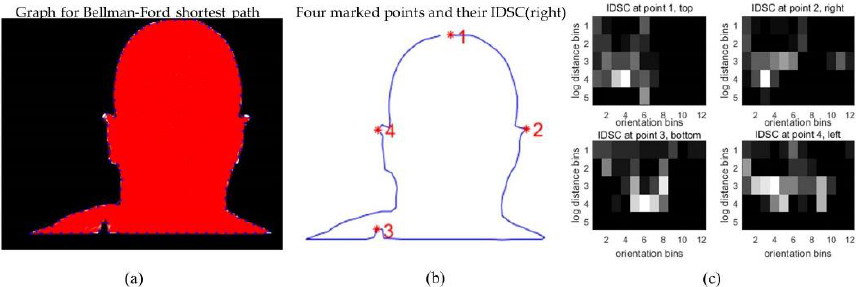
Figure 2. Schematic illustration of face silhouette feature descriptors based on Inner-Distance Shape Context (IDSC). ( a ) Bellman-Ford shortest path graph built using face silhouette landmark points; ( b , c ) Four marked points and their corresponding IDSC feature histograms.